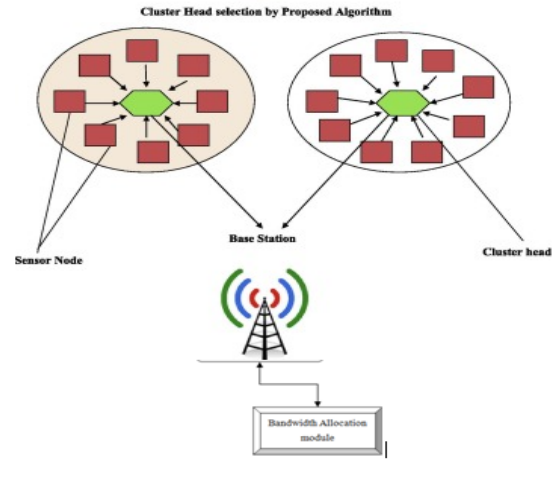
Figure 1. Proposed system